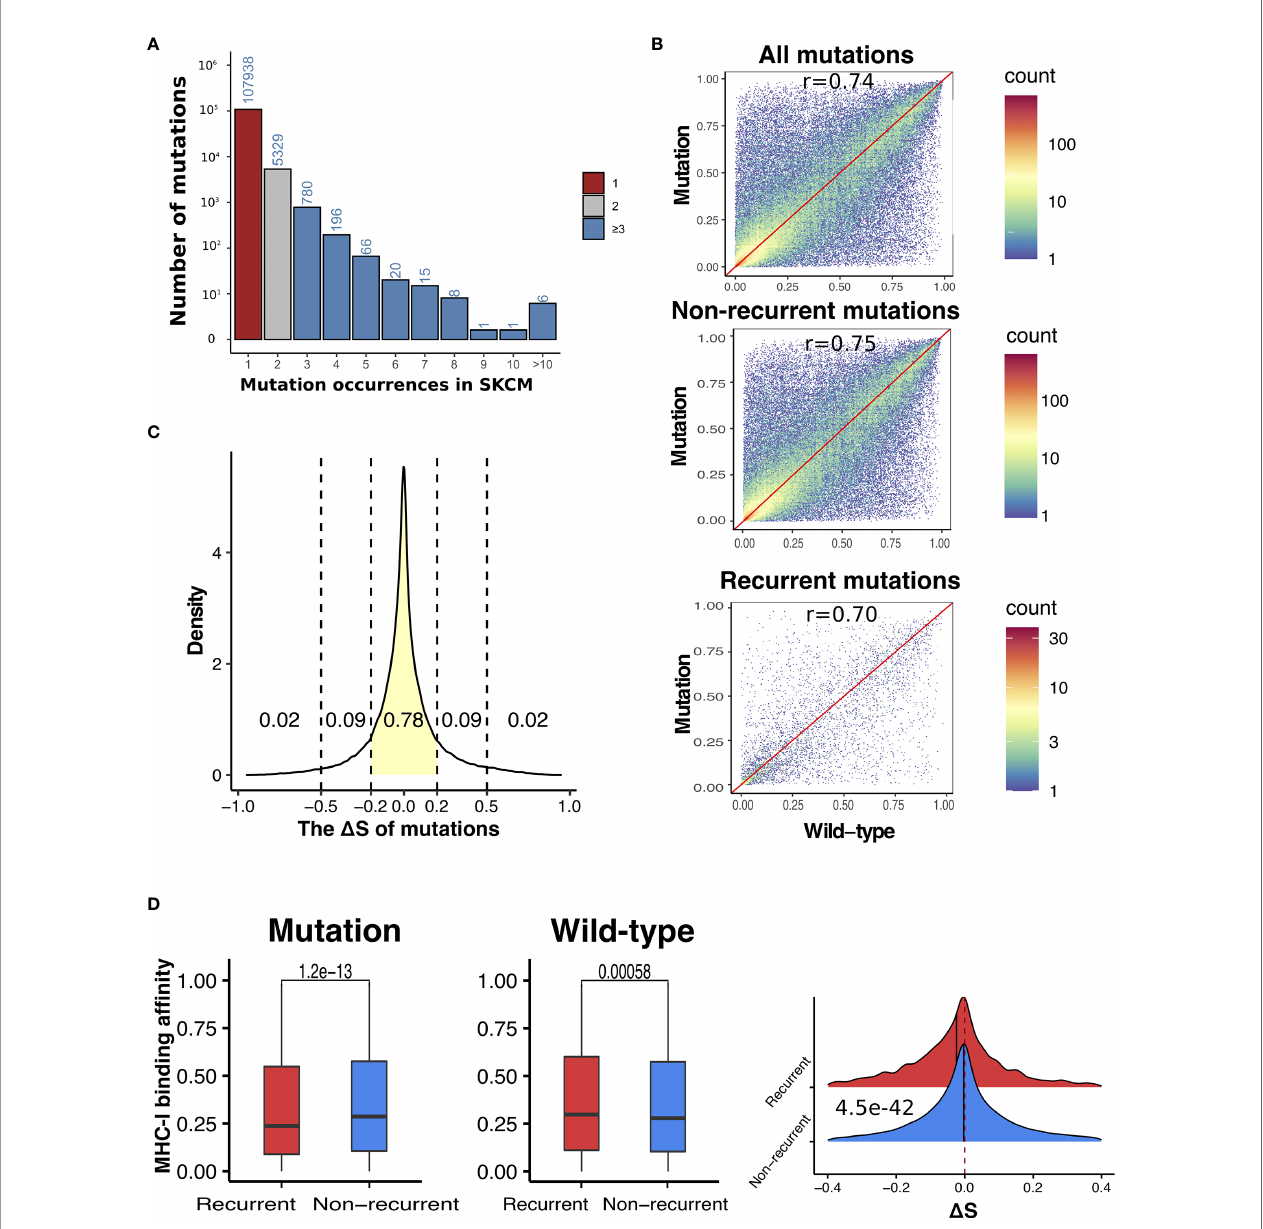
FIGURE 2 | Recurrent somatic mutations have signi fi cantly lower D S than non-recurrent mutations in SKCM. (A) The distribution of occurrences of non-synonymous mutations in SKCM. Mutation count was calculated as the number of melanoma patients harboring a speci fi c somatic mutation. Based on the distribution, we de fi ned recurrent mutations (blue) as those presenting in at least three melanoma samples, and non-recurrent mutations (red) as those presenting in only one sample. (B) Correlations between antigens derived from mutations (all, non-recurrent, and recurrent) and the corresponding wide-type in MHC-I binding af fi nities. (C) The density plot of D S, which was de fi ned as the difference between the MHC-I binding score of mutant and wild-type antigens. (D) Comparison between recurrent vs non-recurrent mutations in the MHC-I binding af fi nity with antigens derived from mutations (left) and the wild-type (middle), as well their difference ( D S) (right). In all plots, P-values were calculated using two-sided Wilcoxon rank-sum test and adjusted for multiple testing by the Holm – Bonferroni